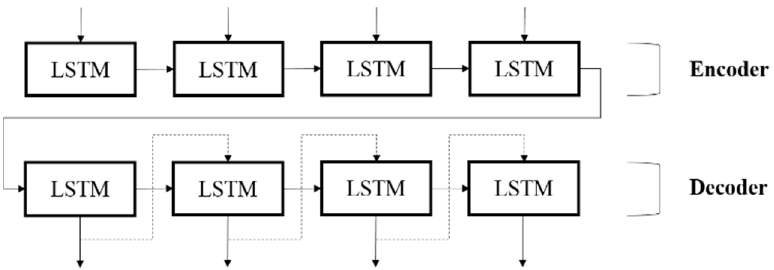
Figure 2. MMVD designed with the encoder and decoder.